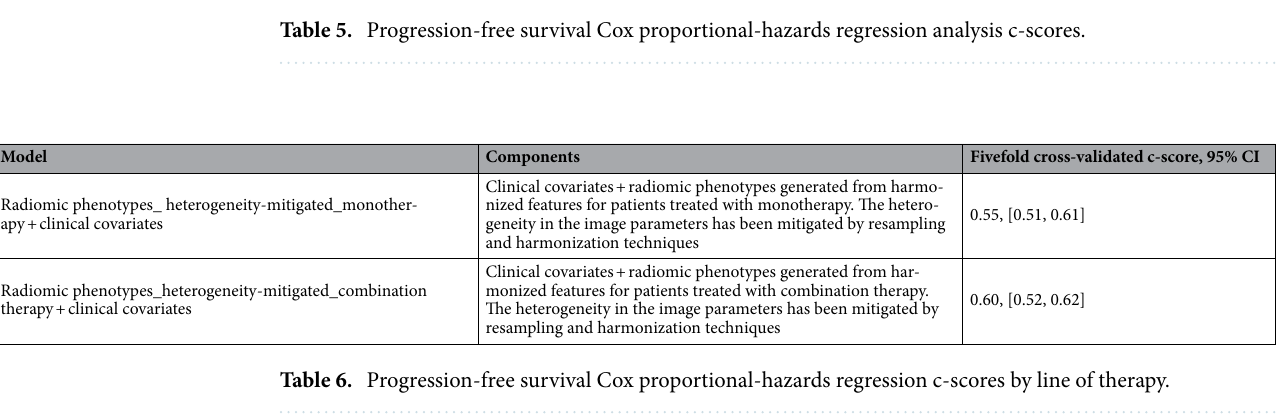
Table 6. Progression-free survival Cox proportional-hazards regression c-scores by line of therapy.